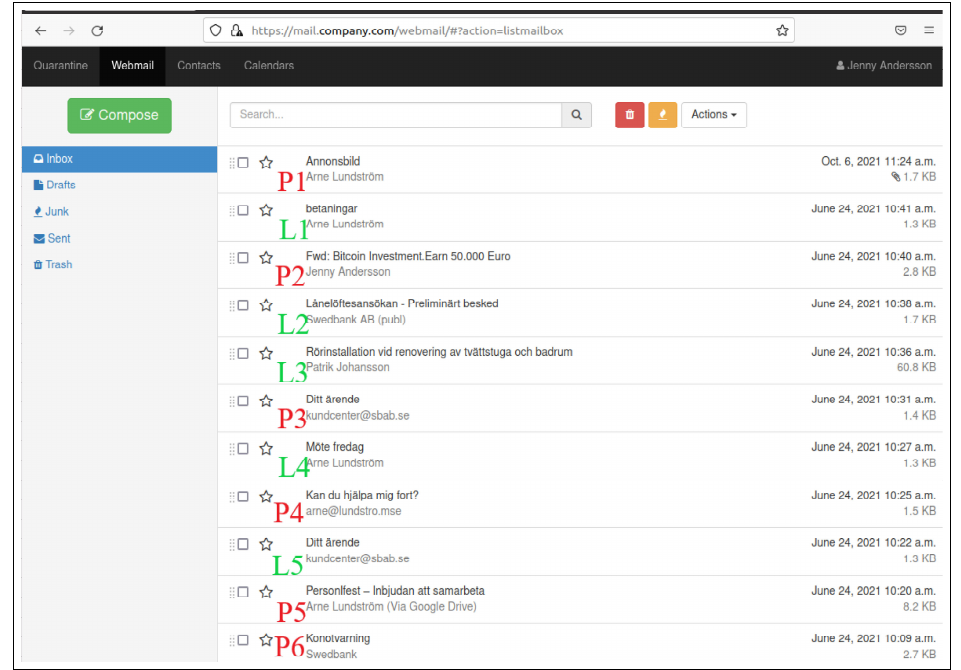
Figure 2. Webmail interface used in the